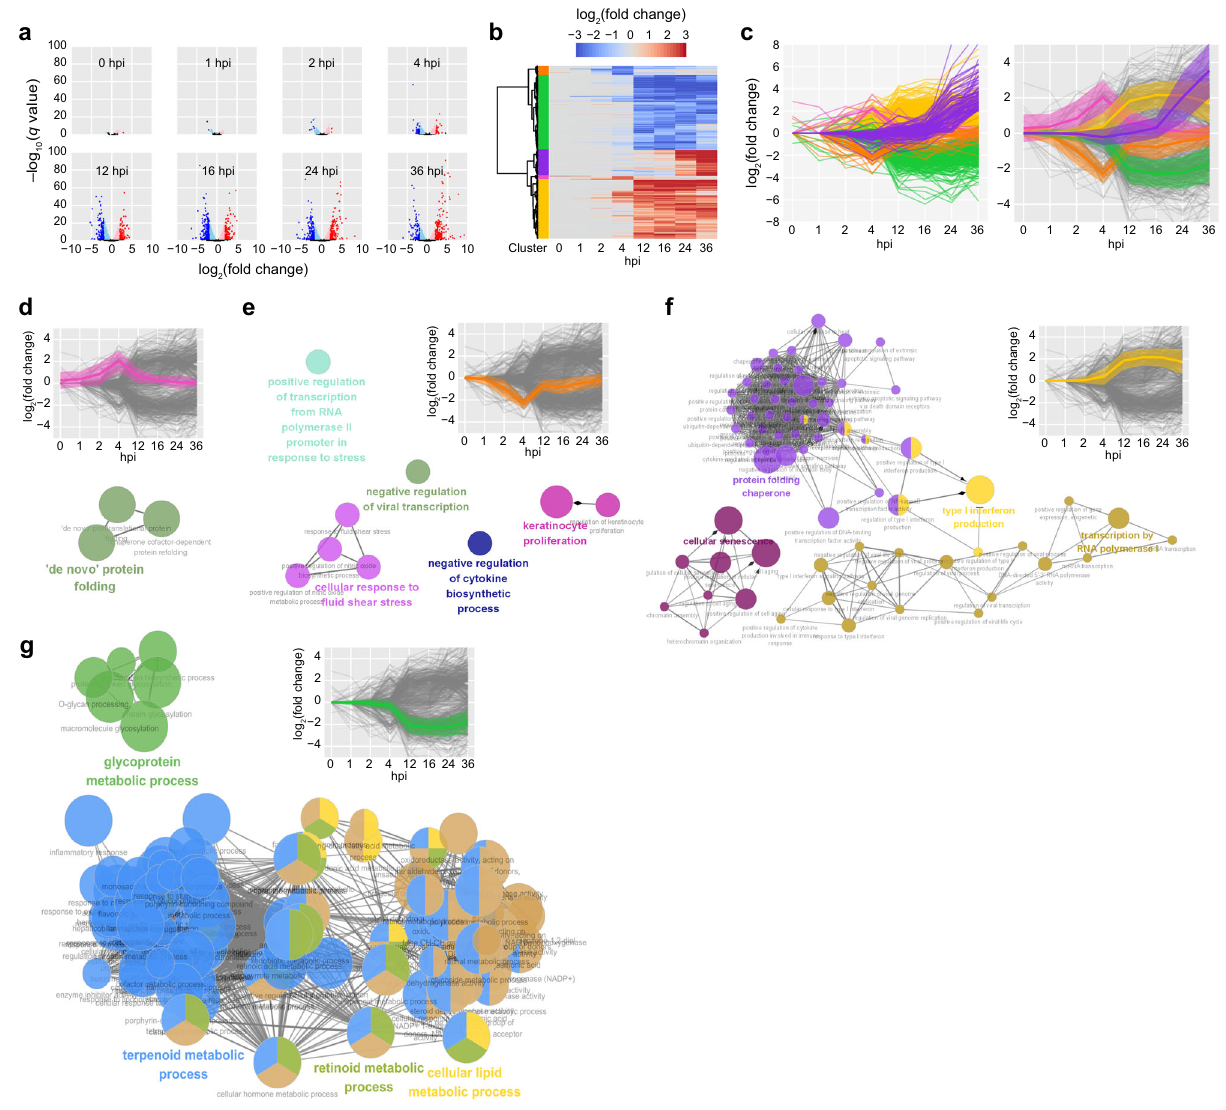
Fig. 5 Early and late responding human genes to SARS-CoV-2 infection. a Differentially expressed genes (DEGs) identi fi ed from RPF-seq data are shown for each time point. From 0 to 36 hpi, RPF-seq levels of human genes were compared with those of uninfected condition. Log 2 (expression fold change) ( x - axis) and statistical signi fi cance ( y -axis; − log 10 -scale FDR-corrected q value) of each gene are displayed (see “ Methods ” ). For a subset of DEGs with q < 0.01, highly upregulated and downregulated DEGs with |log ≥ 2.0 are indicated in red and blue, respectively, and moderately 2 (expression fold change)| upregulated and downregulated DEGs with |log 2 (expression fold change)| < 2.0 are indicated in pink and light blue, respectively. b Hierarchical clustering of the DEGs displayed in a . The genes identi fi ed as DEGs at least for one time point were clustered with respect to their temporal expression patterns (see “ Methods ” ). Upregulation and downregulation in comparison to the uninfected condition is indicated in red and blue, respectively. c Temporal expression changes of the identi fi ed DEGs color-coded for the fi ve clusters determined in b (left). Overall expression changes for each cluster were also depicted by mean log 2 (expression fold changes) (right). The light-colored shades for each line indicate the standard deviations, and the gray lines represent the expression changes of individual DEGs (left). For the DEGs included in each cluster determined in b , Gene Ontology (GO) enrichment analysis were performed and GO terms associated with early ( d , e ) and late ( f , g ) responding clusters in response to the viral infection are shown. For each cluster, top fi ve GO terms chosen based on statistical signi fi cance and their temporal expression patterns are displayed (see “ Methods ” levels of mRNAs. Together with our observation of the high level of TI at TIS-L (Fig. 3f), we postulate that the regulatory impact of TIS-L on the SARS-CoV-2 translatome may play critical roles for SARS-CoV-2 pathophysiology.